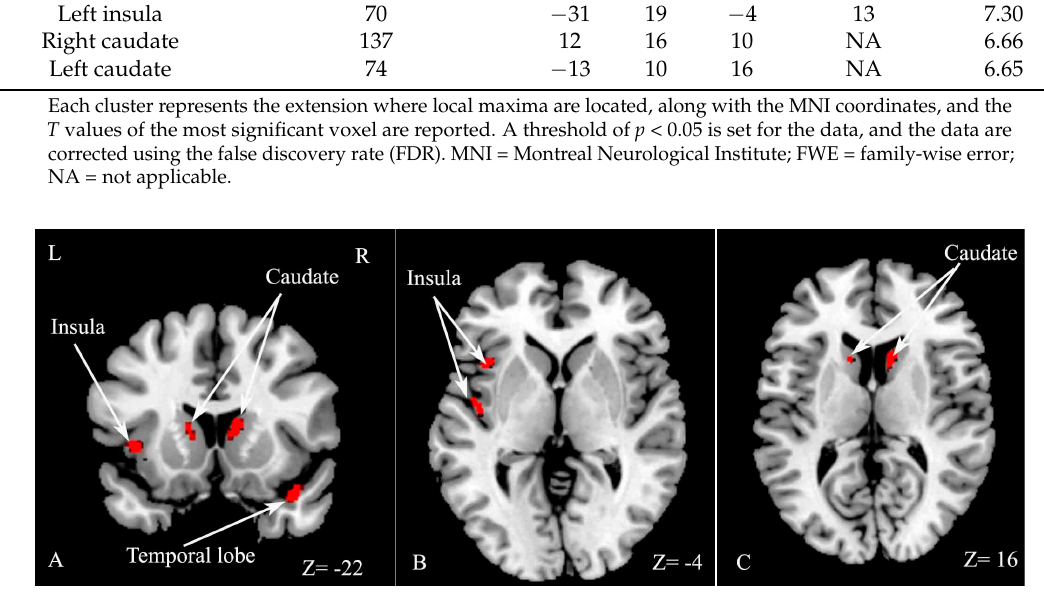
Figure 4. Statistical parametric mapping (SPM) regions exhibiting decreased gray matter (GM) volume in CI patients compared with CP patients ( p < 0.05, FWE corrected for multiple comparisons). SPM regions exhibiting significant GM loss including right temporal lobe, left insula and bilateral caudate ( A ); left insula ( B ); bilateral caudate ( C ).